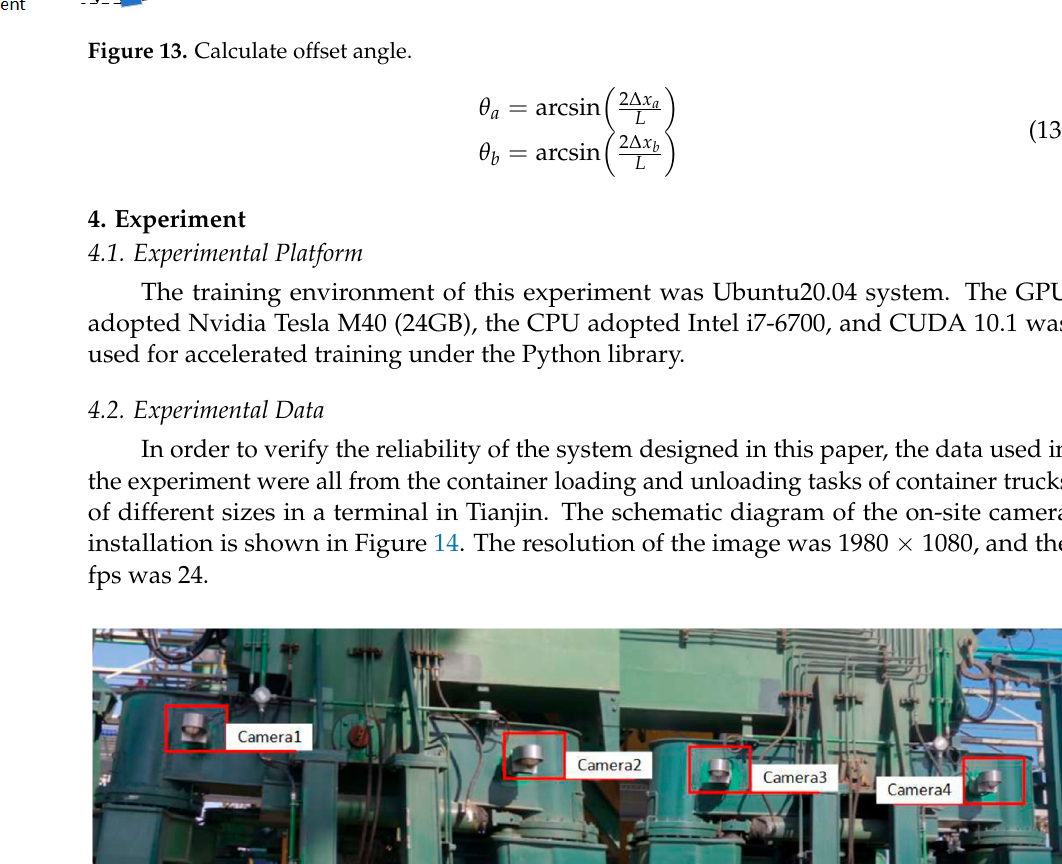
Figure 13. Calculate offset angle.